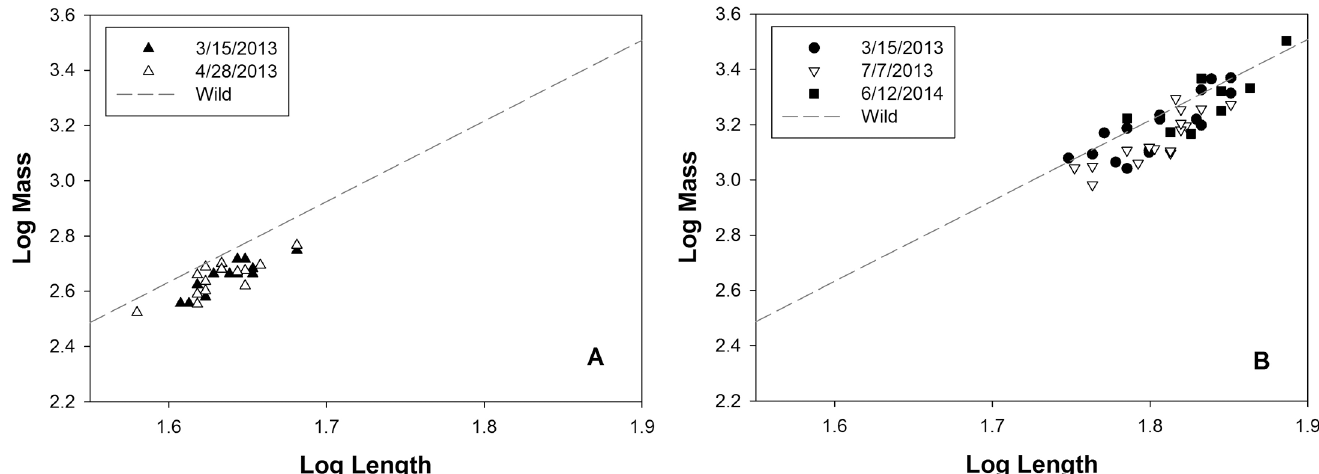
Fig 5. Change in body condition of reintroduced salamanders, compared to wild-caught conspecifics. (A) Salamanders reintroduced at the Heihe River. (B) Salamanders reintroduced at the Donghe River. The regression line: log[Mass] = -2.039+2.920 * log[TBL] (R 2 = 0.98, P < 0.001) was constructed using data obtained from previously published papers, indicating body condition of wild-caught giant salamanders [ 20]. A dot above the regression line indicates that this animal has better body condition than wild salamanders with the same total body length, whereas a dot under the regression line indicates a worse body